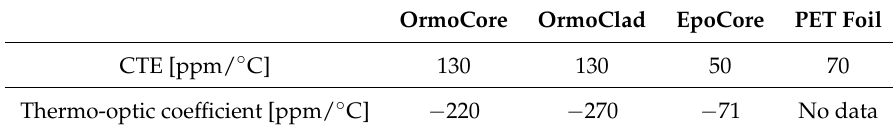
Table 2. The thermal expansion coefficients (CTE) and thermo-optic coefficients.